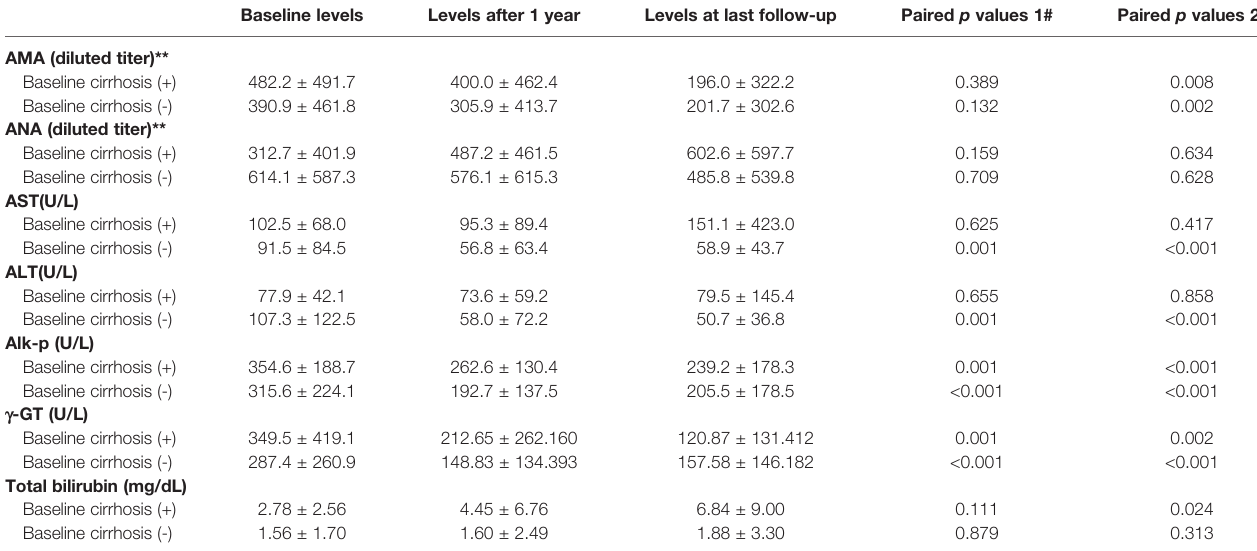
AMA, antimitochondrial antibody; ANA, antinuclear antibody; AST, aspartate transaminase; ALT, alanine aminotransferase; Alk-p, alkaline phosphatase; g -GT, gamma- glutamyltransferase. #, paired-t-test p values for the comparisons between levels at baseline and levels after 1 year for variable variables.* paired-t-test p values for comparisons betweenlevelsatbaselineandlevelsat fi nalfollow-upforvariablevariables;**,Thedilutedtiter “ 1,X ” waspresentedas “ X ” ,andthemean±standarddeviationofXwasshowninthetable. For example, the diluted titers such as 1,40, 1,80, 1,160, 1,320, 1,640, 1,1280 were presented as 40, 80, 160, 320, 640 and 1280,